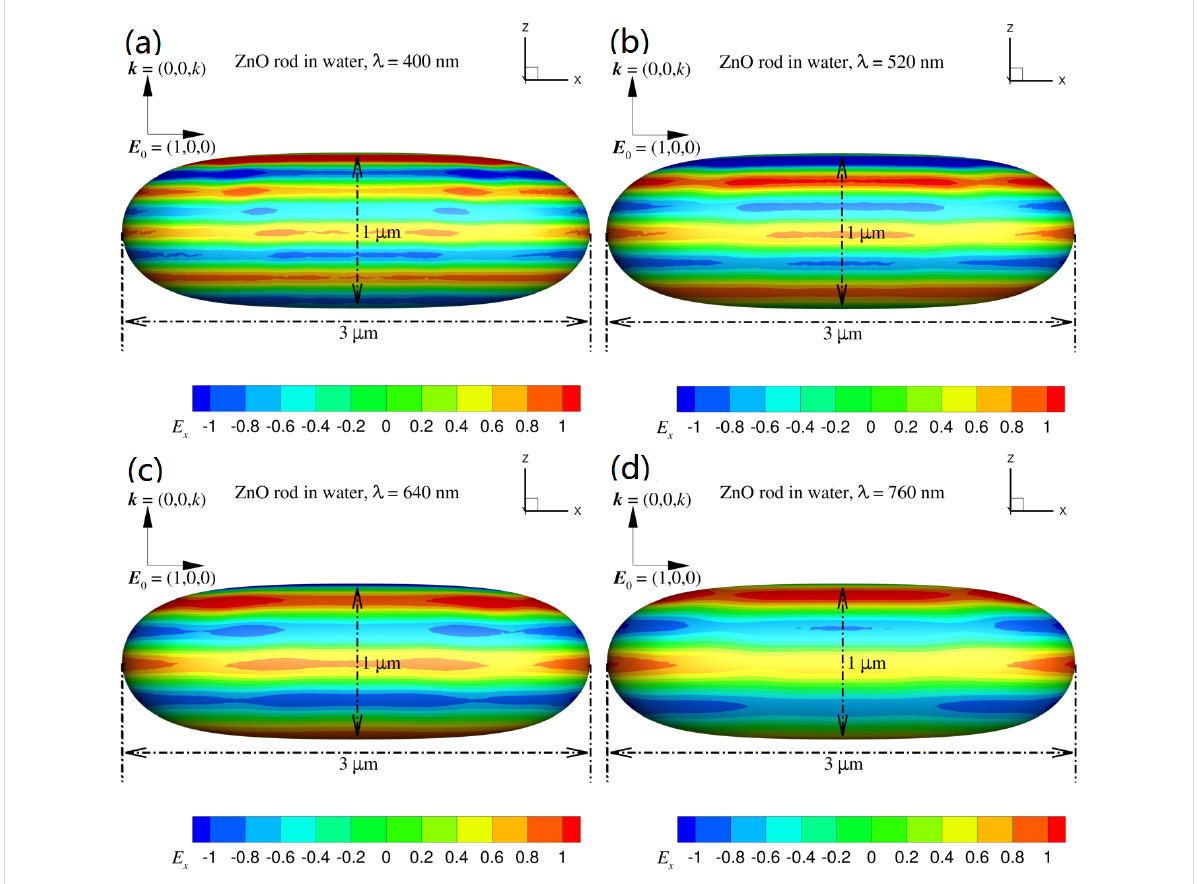
Figure 7: The total field on the surface of a ZnO rod with length of 3 µm and width of 1 µm due to an incident electric field E inc = (1,0,0) exp( ikz ) with λ = 400 to 760 nm. The magnitude of the field, E x , is given by the color scale.